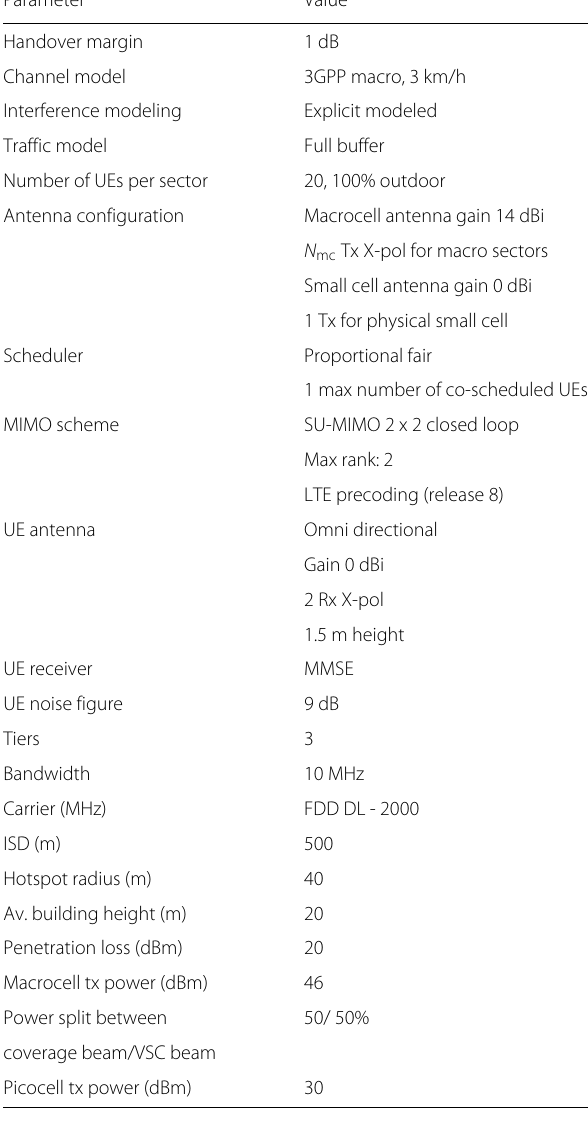
Table 1 System level simulation parameters for urban scenario Parameter Value Handover margin 1 dB Channel model 3GPP macro, 3 km/h Interference modeling Explicit modeled Traffic model Full